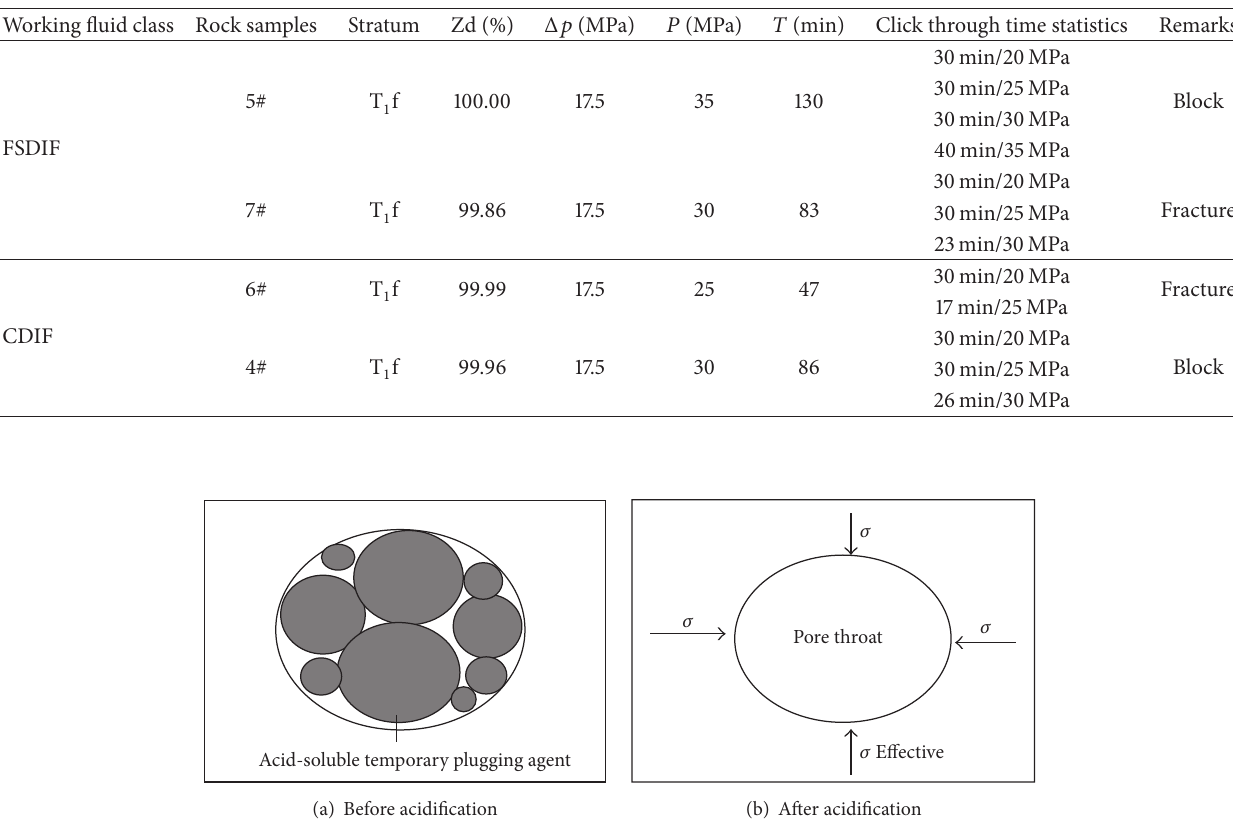
Table 6: Table contrasting the shielding ring strength of the CDIF and FSDIF.